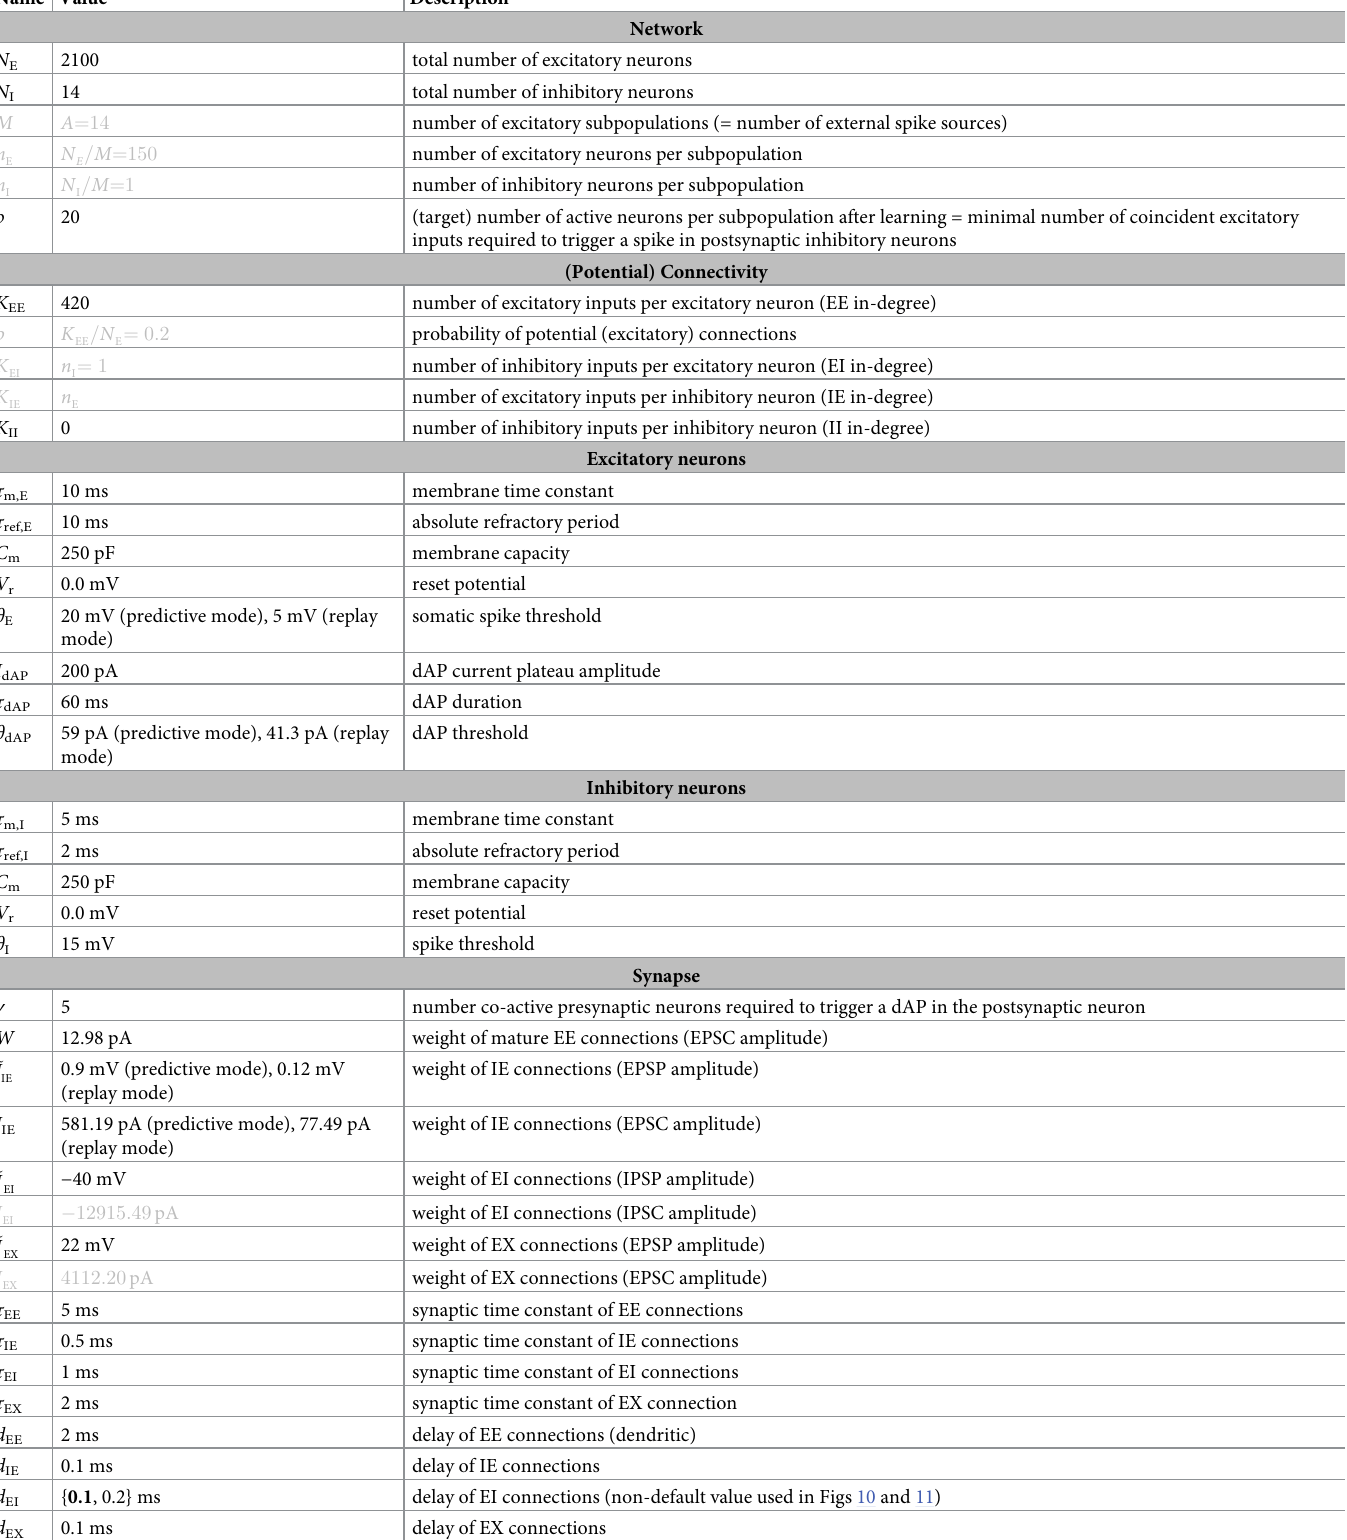
Table 2. Model and simulation parameters. Parameters derived from other parameters are marked in gray. Bold numbers depict default